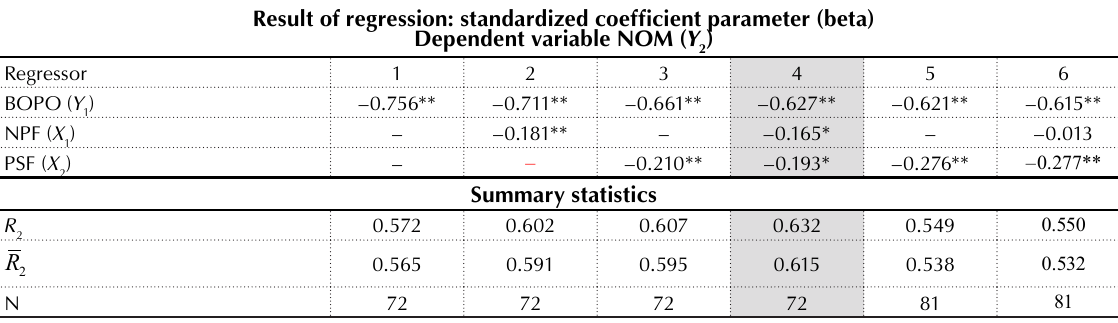
Table 4. The structural path for equation 2